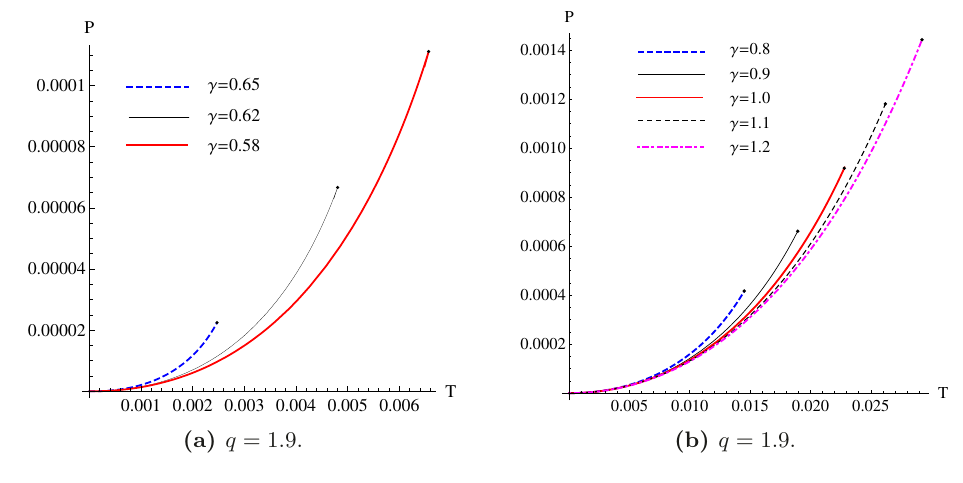
Figure 4. The coexistent curve of P